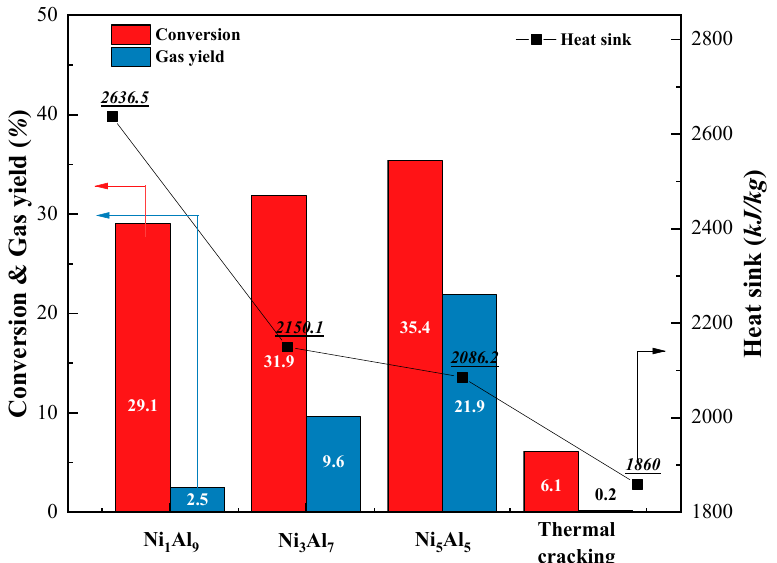
Figure 6. Conversions, gas yields, and heat sinks of the NiAl 2 O 4 catalysts with various Ni/Al ratios